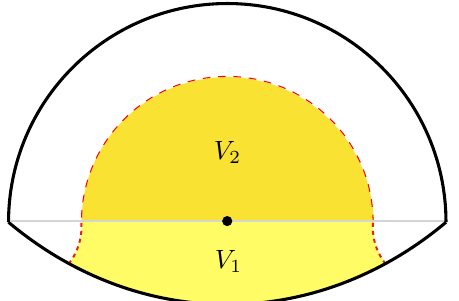
Figure 5. Division of the constant time slice inside the cuto(cid:11) surface to two di(cid:11)erent portions which we use in evaluating the volume integrals for the CV conjecture. V 1 is the volume in the defect region and V 2 is the volume outside the defect